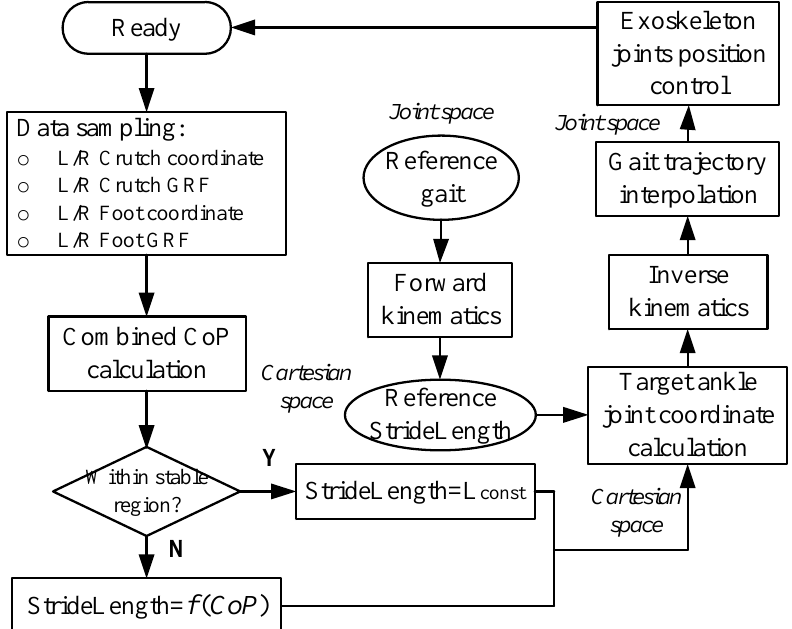
Figure 6. Algorithm for gait planning based on combined CoP. Once combined CoP is calculated, the stride length is obtained with a predefined mapping function. Compared with the reference stride length, the target gait trajectory is determined by converting the inverse kinematics. L const is a constant stride length. When the combined CoP locates within a stable region (between L / R legs), the next stride length is determined to be L const